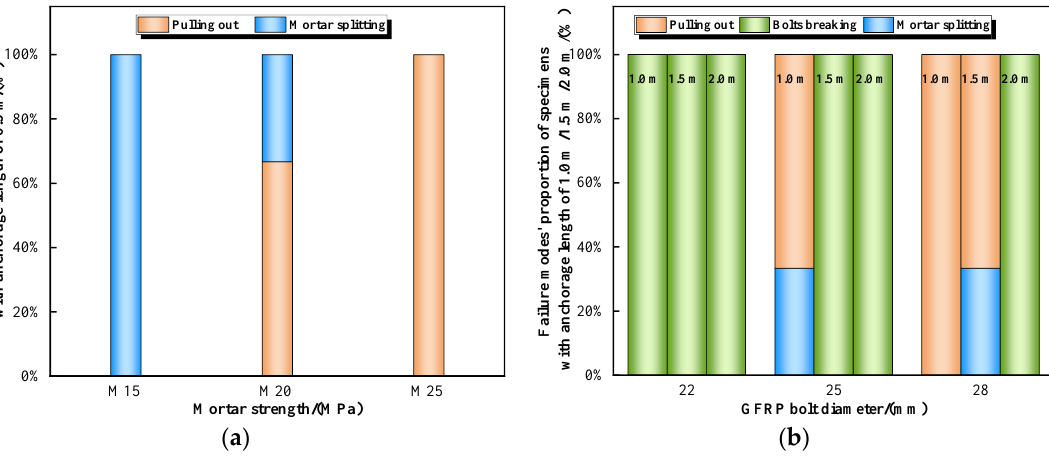
Figure 7. Proportion of specimens’ failure modes . ( a ) Anchorage length = 0.5 m. ( b ) Anchorage length = 1.0 m, 1.5 m, 2.0 m.